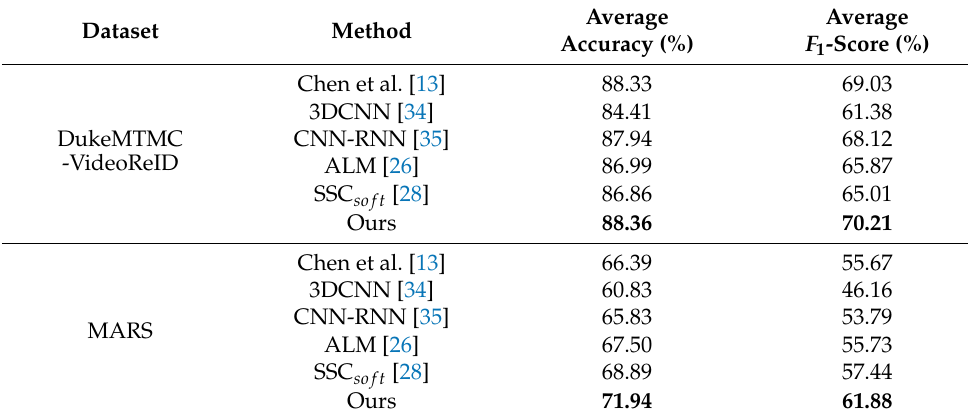
Table 2. Comparisons of the results obtained for the occlusion samples of the DukeMTMC-VideoReID and MARS datasets. The bold indicates the best result.